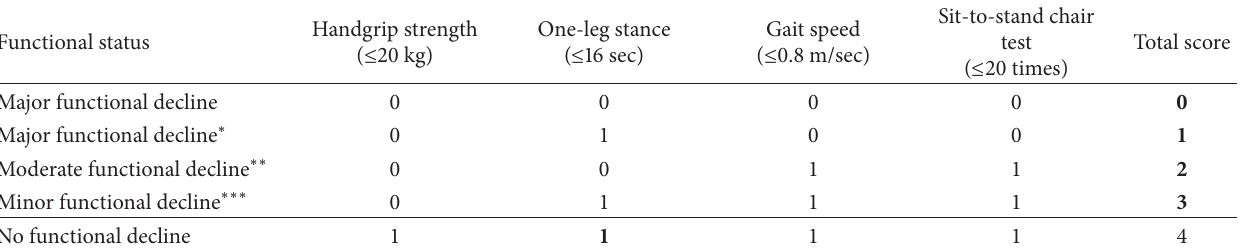
Table 2: Assessment and scoring of the functional performance and corresponding cut-off